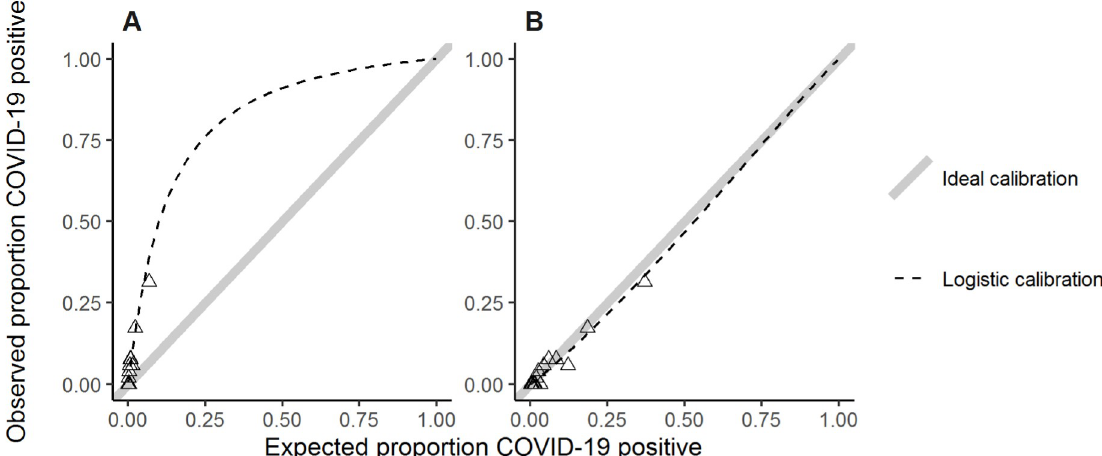
Fig 3. Calibration plot. A. In the calibration plot the proportion of observed COVID-19 positives versus expected proportion of positives are plotted. Observations are grouped with an average of 50 observations per group. The expected probabilities follow from applying the inverse logit function to the CoLab-linear predictor. If the observed proportion in an external dataset is lower than the expected proportion, this means risks are over-estimated, if the observed fraction is higher, risks are under-estimated. Ideally, observed proportions are equal to expected proportions, this ideal-calibration-line is shown as a straight line through the origin with a slope of 1. The logistic calibration line is a logistic regression fit of the predicted probabilities. B. Using the intercept and/or slope from the logistic regression model, recalibrated probabilities were obtained and plotted in a second calibration